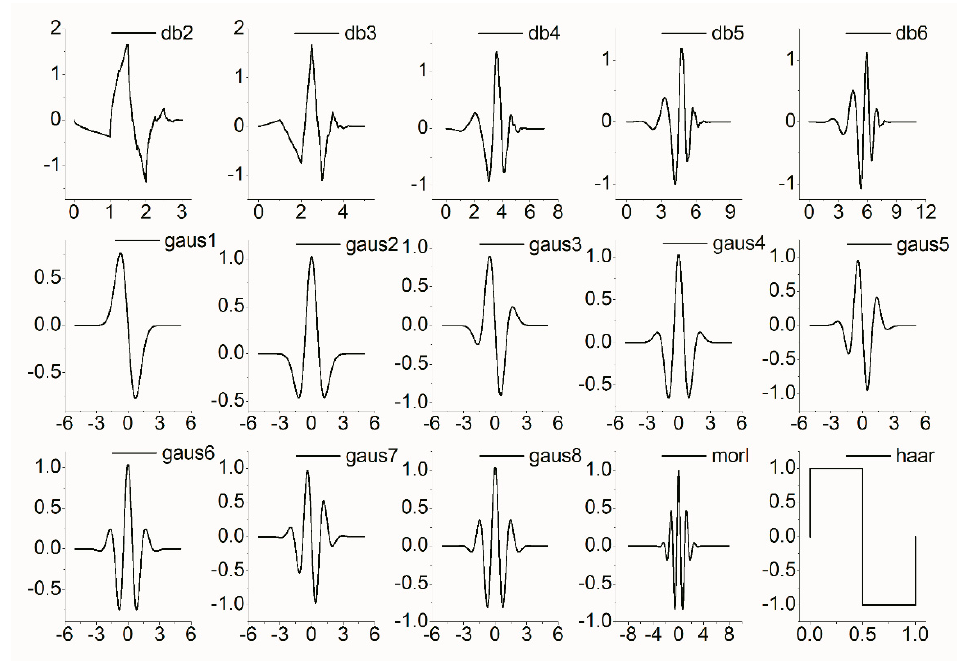
Figure 2. The repository of the mother wavelets used in the adaptive selection of the optimum mother waveform in the wavelet transform.